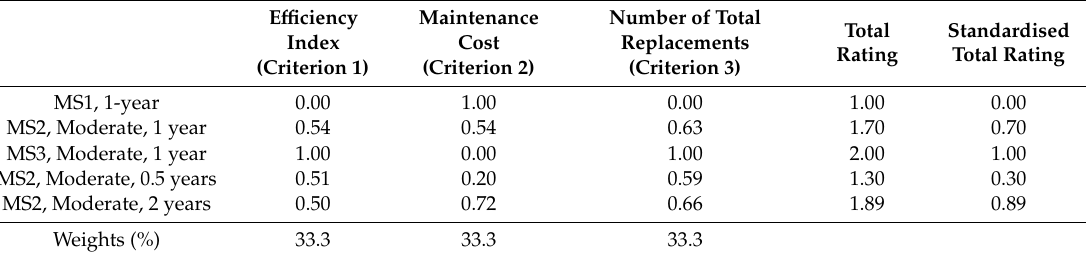
Table 9. Scenario 1: with equal weights.